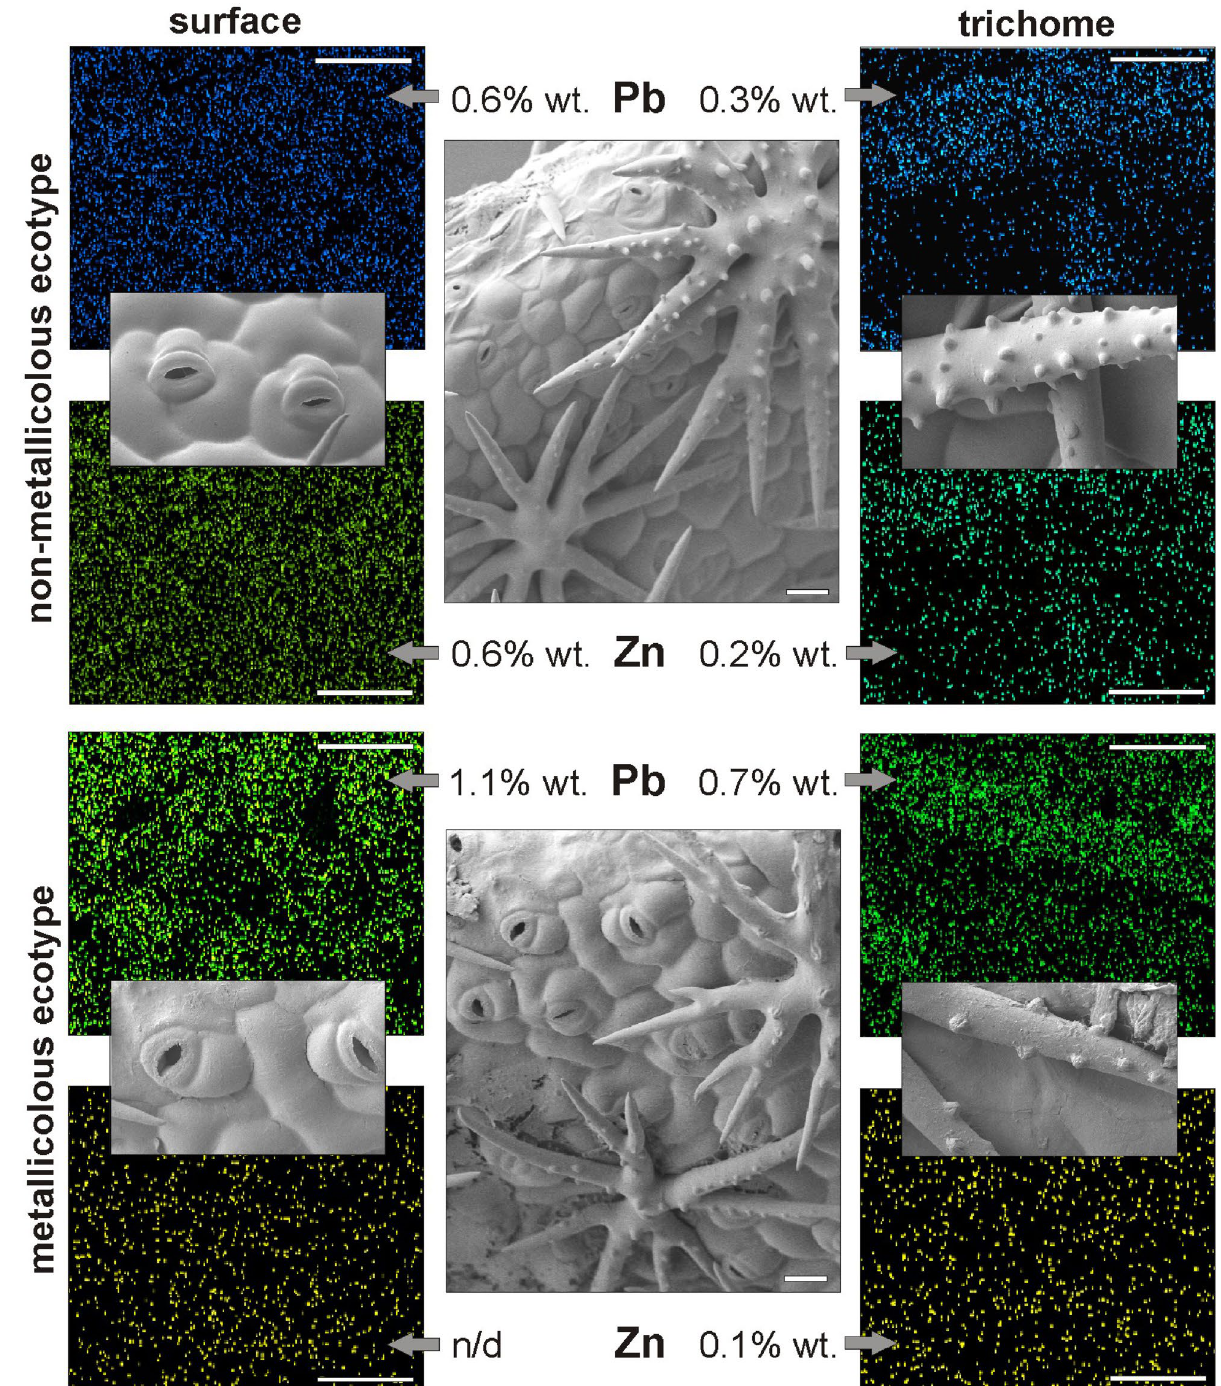
Figure 1. SEM–EDX micrographs of leaf surface and trichomes presenting lead (Pb) and zinc (Zn) distribution and content in contrasting Alyssum montanum ecotypes cultured on heavy metal-enriched medium. Bar 25 μm. n/d not